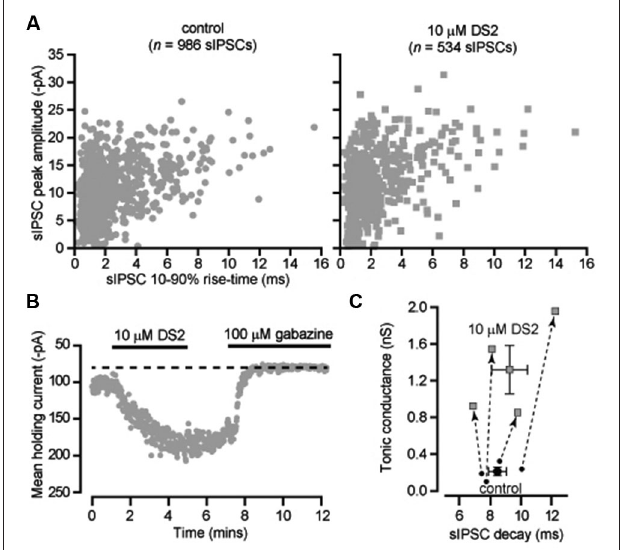
FIGURE 2 | DS2 enhances the tonic conductance recorded from dLGN thalamic relay neurons but does not alter IPSC properties . (A) Scatter-plots of individual IPSC peak amplitude (pA) and 10–90% rise-time (ms) recorded from a dLGN thalamic neuron (V H − 70 mV) in the absence (control) and presence of 10 µ M DS2. (B) Time course of the average holding current calculated every 1 s from consecutive 100 ms current epochs during the application of 10 µ M DS2 and 100 µ M gabazine. (C) Scatter plot of the average tonic conductance and average sIPSC decay before and after DS2 application. The data for individual cells are linked by dashed lines and arrows to illustrate the consistent increase in the tonic conductance that took place with no consistent change in the estimated IPSC decay. Superimposed on this plot are the average values across all cells (mean ± SEM, n = 4).